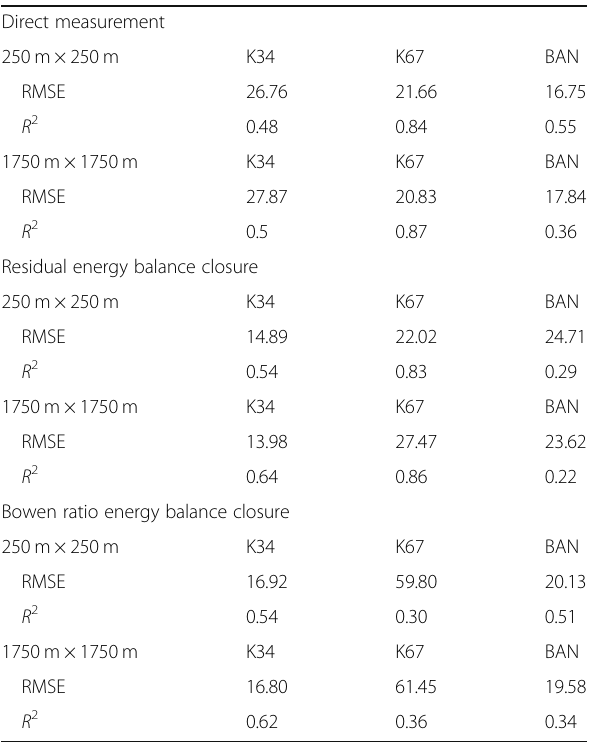
Table 5 Impact of footprint 250 m × 250 m (6.25 ha) vs. 1750 m × 1750 m (306.25 ha) of flux towers on the performance of ET-Amazon